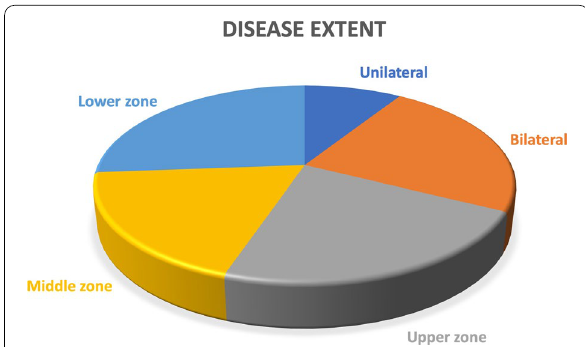
Fig. 2 Pie chart showing the distribution of all studied